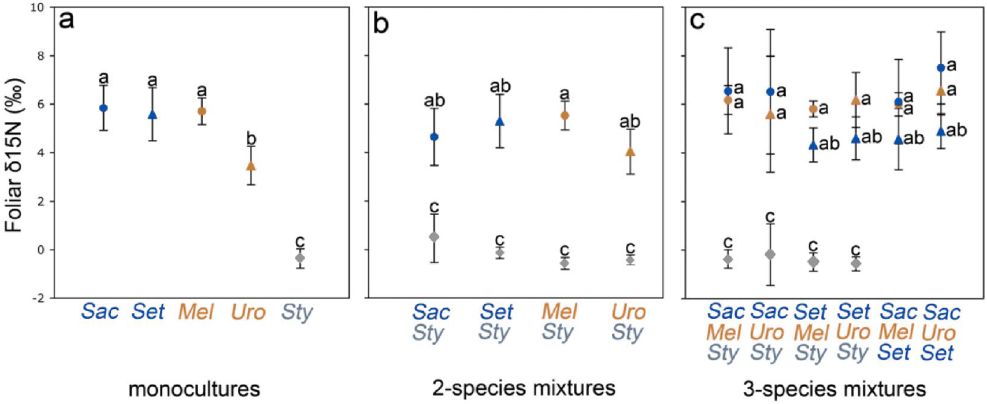
Figure 4. Foliar δ 15 N of native and alien Cerrado plants in a mesocosm experiment. Foliar samples were collected at harvest (t = 7 weeks) of two alien grasses ( Melinis minutiflora— orange circles ) and Urochloa decumbens— orange triangles), two native Cerrado grasses ( Saccharum asperum— blue circles and Setaria poiretiana— blue triangles ) and a native leguminous forb ( Stylosanthes guianensis— grey losanges) growing in monocultures or in mixtures of two or three species. Symbols show mean values (+ SD) of 9–10 replicates for all species in panels a and b, and for M. minutiflora , U. decumbens and S. guianensis in panel ( c ). For panel ( c ) S. asperum and S. poiretiana had 2–8 and 6–9 replicates, respectively. Only samples from the unfertilized mesocosms were analyzed on foliar δ 15 N. Symbols placed in the same vertical line in panels ( b ) and ( c ) show values from a species combination treatment. Different letters indicate significant differences at the p < 0.05 level (Tukey contrasts after Anova Type